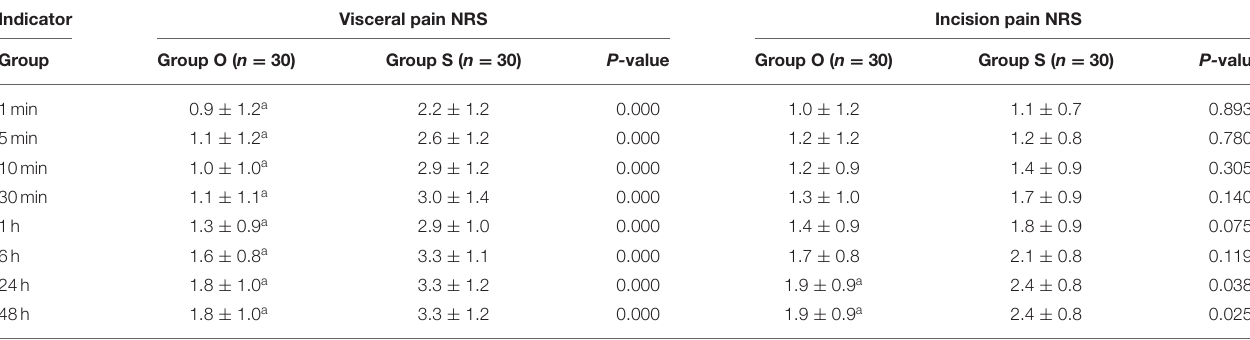
TABLE 4 | Comparison of NRS scores between the two groups after extubation. Indicator Visceral pain NRS Incision pain NRS Group Group O ( n = 30)